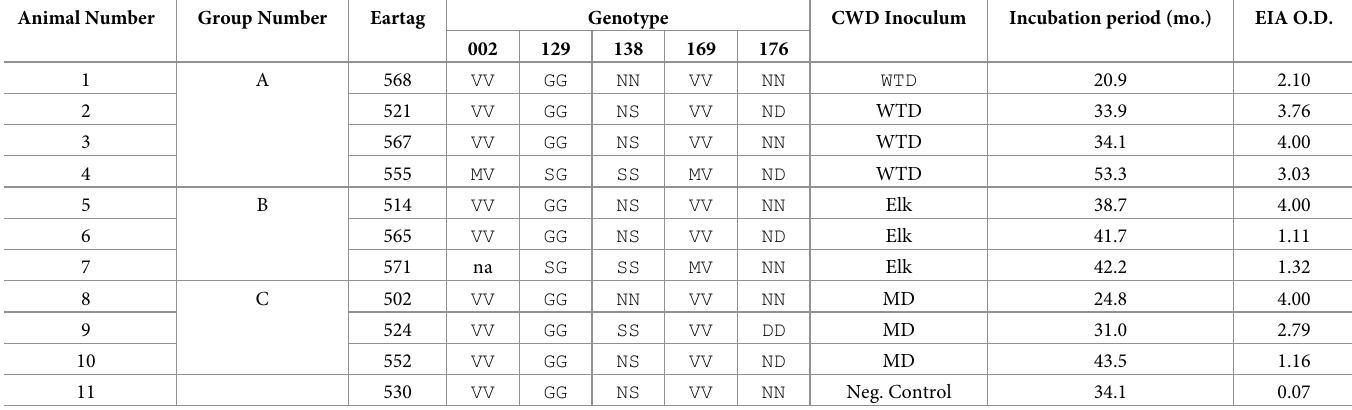
Table 2. Animal experimental summary of genotype, inoculum, survival period, and EIA in reindeer inoculated intracranially with the agent of chronic wasting dis- ease from elk, white-tailed deer and mule deer. Animal